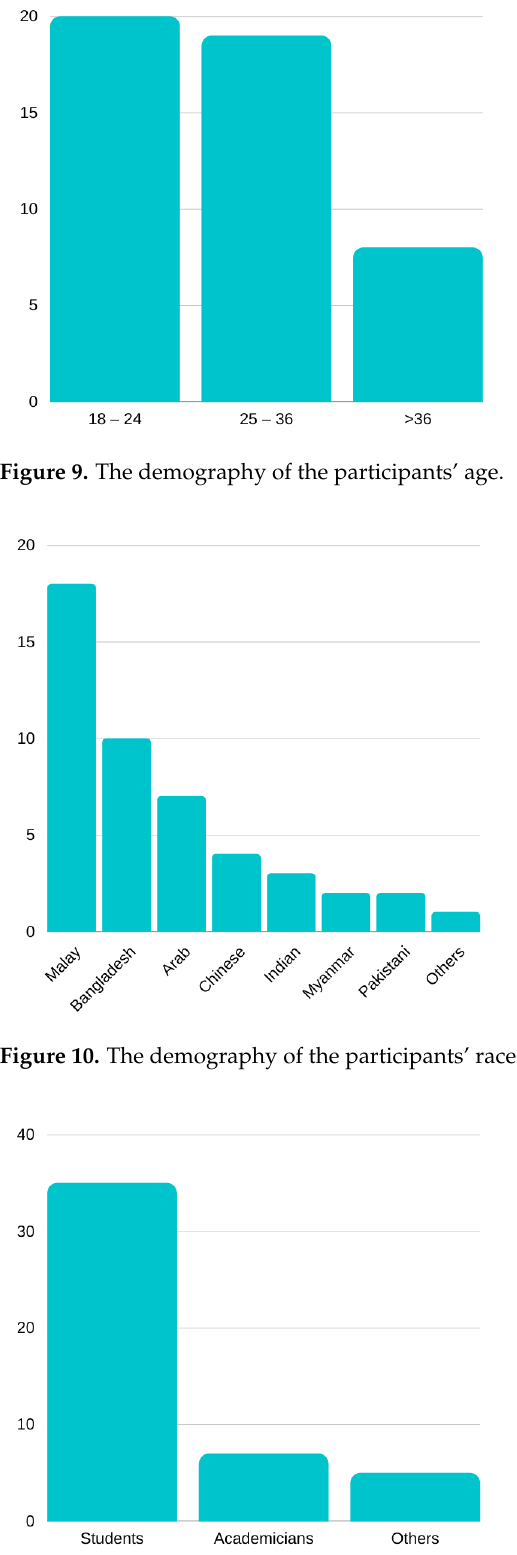
Figure 11. The demography of the participants’ occupation .